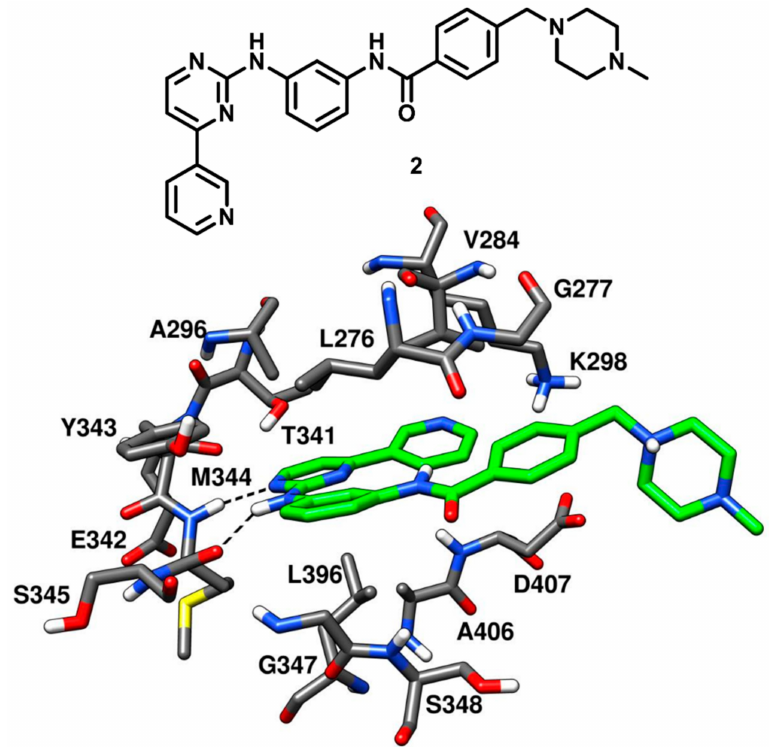
Figure 4. 2D structure of 2 and X-ray structure of c-Src kinase in complex with 2 (PDB ID: 1Y57). Active site residues of c-Src kinase and the enzyme–inhibitor H-bond interactions are